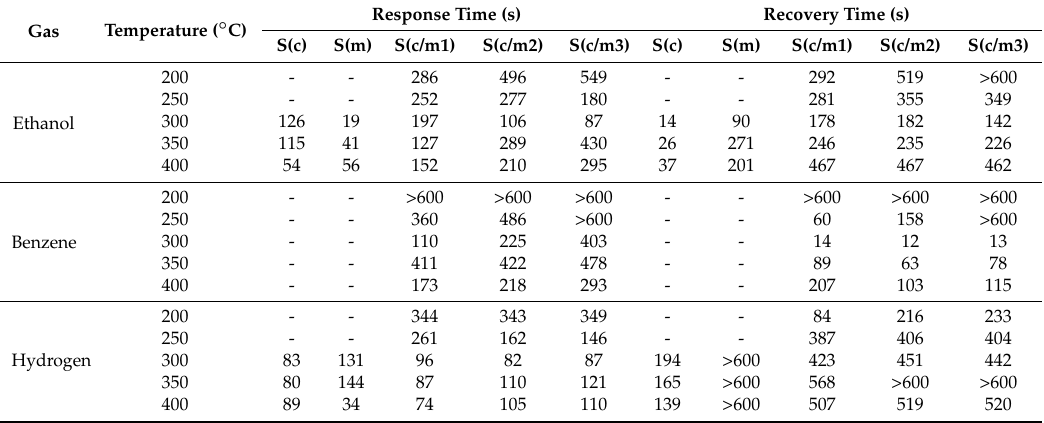
Table 2. The response and recovery times of the gas sensors to ethanol, benzene and hydrogen.